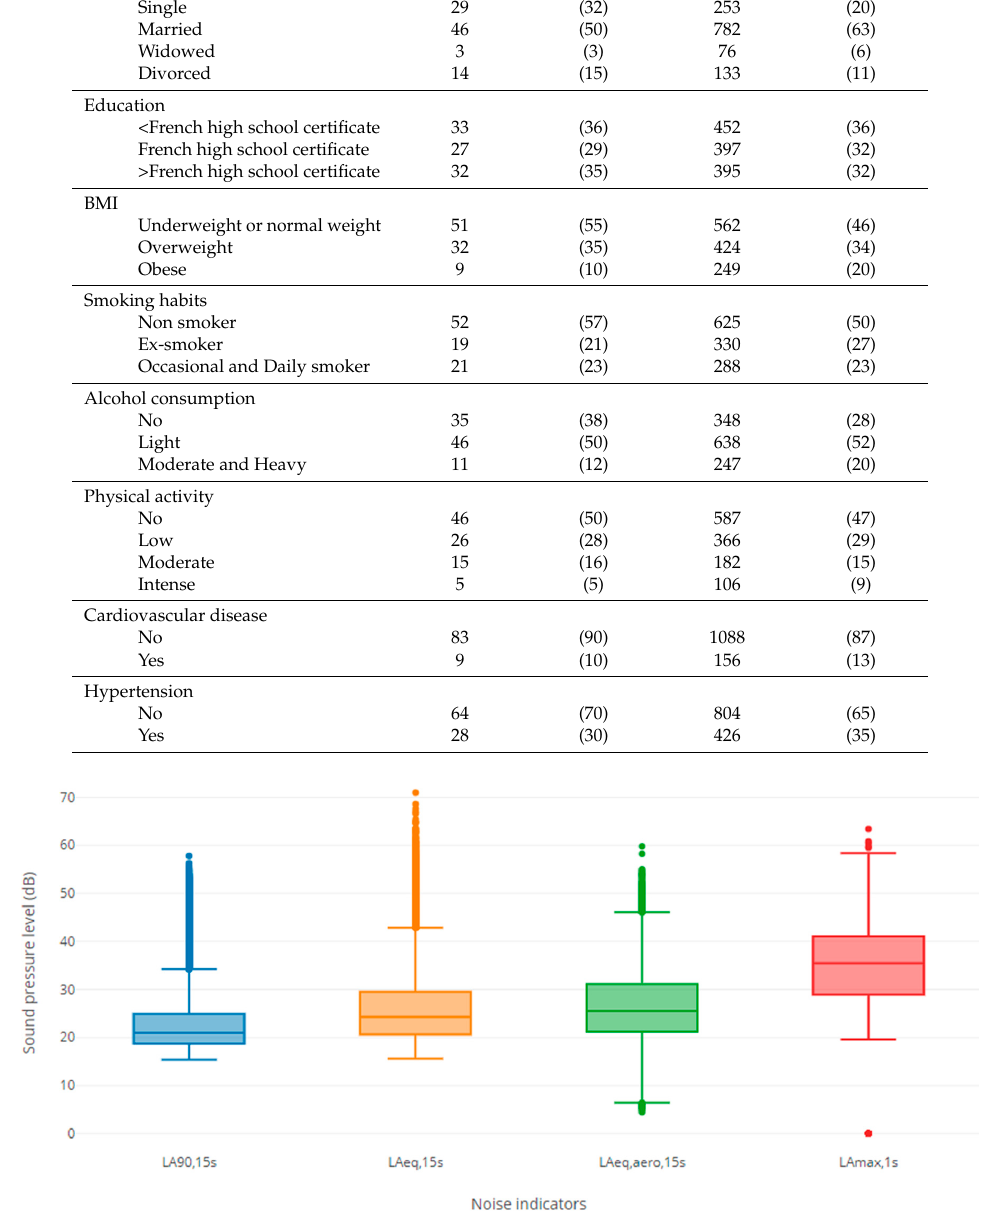
Figure 1. Box plots of the sound level indicators measured indoors during the Actiheart measurement